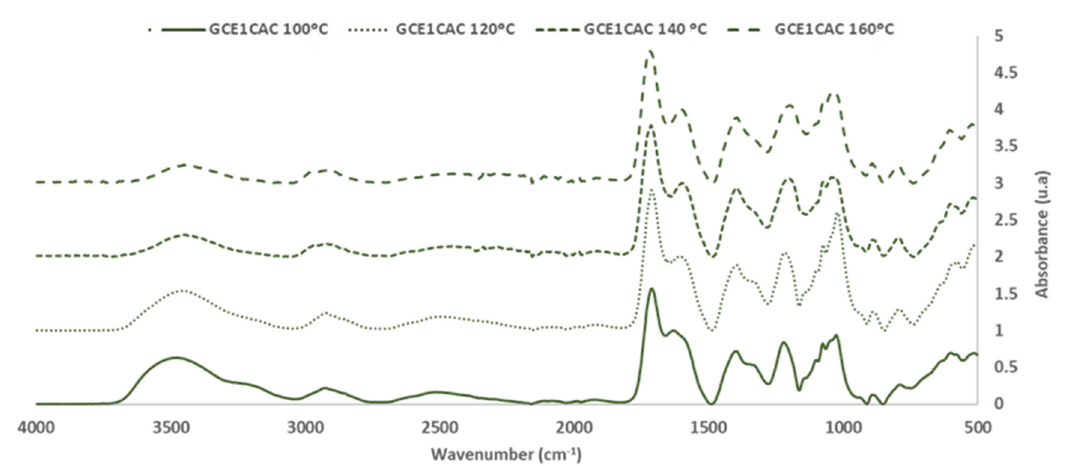
Figure 9. FTIR spectra: Citric acid and Grape cane extract GC E1 cured with citric acid (43% on adhesive weight, dry basis) at 100–180 °C (400–4000 cm − 1 ).